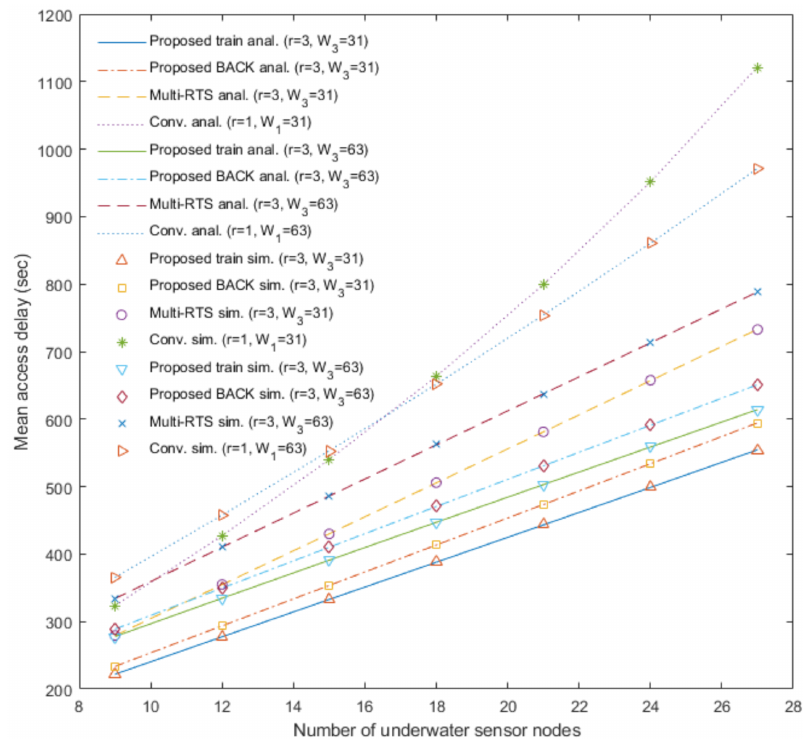
Figure 6. Mean access delay of the proposed underwater multi-DATA train protocol, the proposed underwater BACK protocol, and the underwater multi-RTS reception protocol with W 3 = 31 and W 3 = 63, and the conventional CSMA / CA protocol with W 1 = 31 and W 1 =